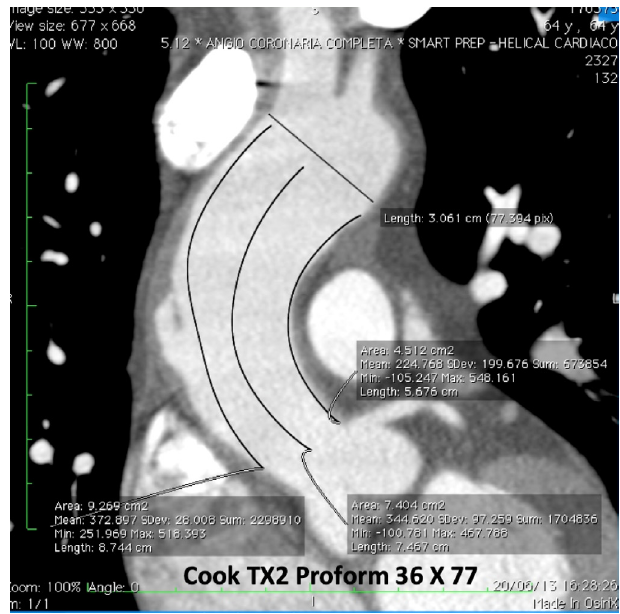
Fig. 3 – Ascending aortic dissection. Planning endovascular treatment with preoperative contrast-enhanced computed